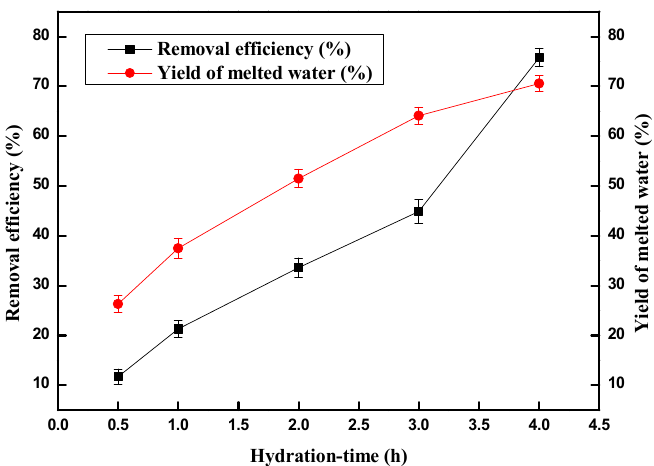
Figure 3. Effect of hydration time on the removal of copper (II) ions and the yield of melted water.